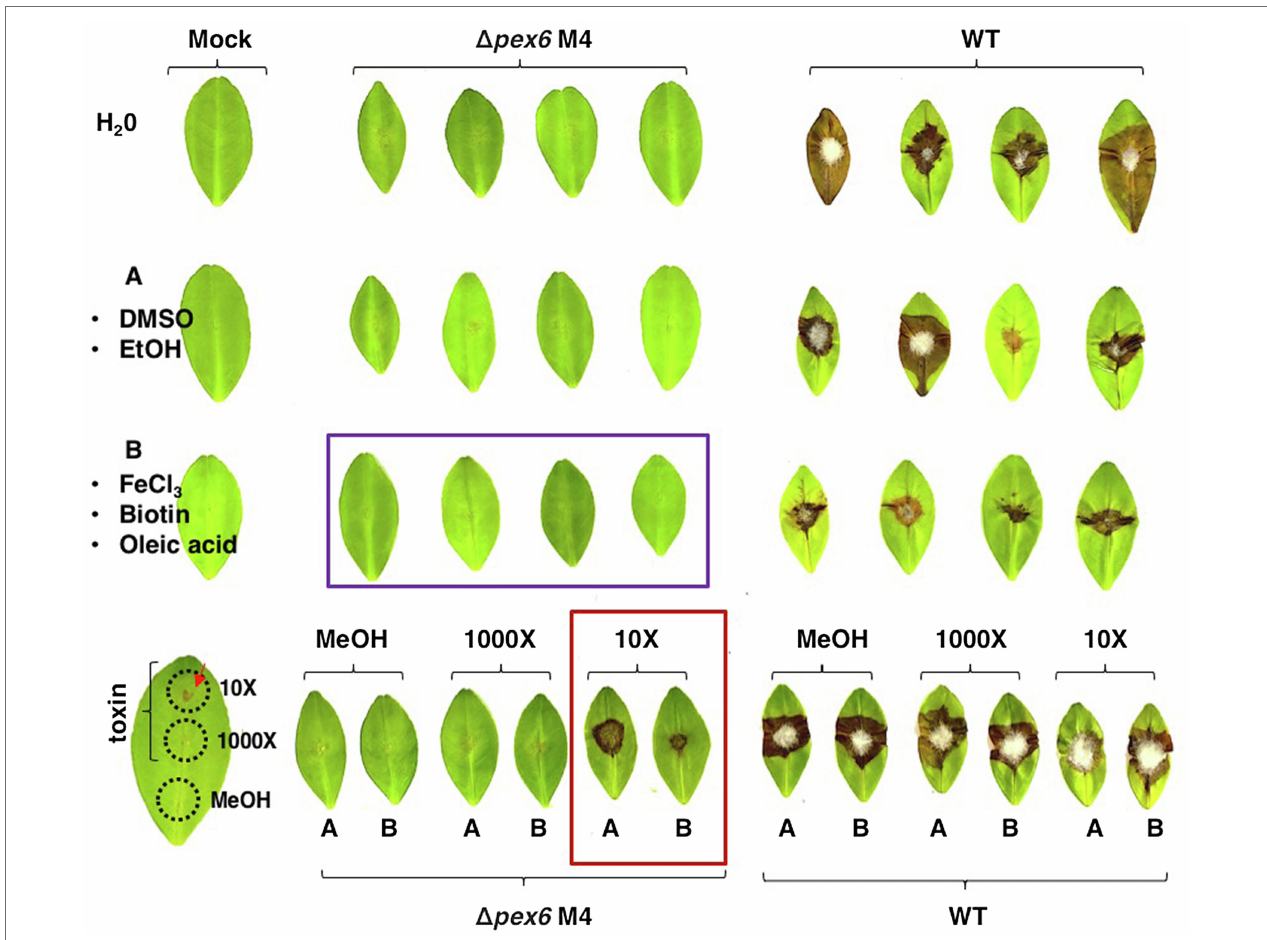
FIGURE 7 | A combination of biotin, oleic acid, and iron fails to restore Δ pex6 virulence on calamondin leaves. Leaves were wounded and treated with dimethyl sulfoxide (10%, DMSO)/ethanol (EtOH) mixture (an A letter with circle), methanol (MeOH), 0.2 mM FeCl 3 /0.1% oleic acid/0.5 μ M biotin mixture (a B letter with circle), or toxin (10X or 1,000X dilution in methanol). After 30 min, 10 μ l of conidia suspensions (10 5 conidia/ml) prepared from wild-type (WT) and ∆ pex6 -M4 were placed on each spot. Leaves treated with water, DMSO/EtOH, MeOH, or toxin alone were used as mock